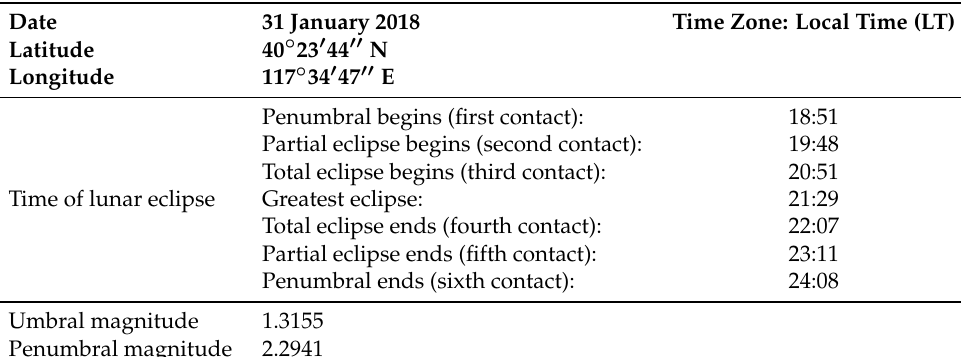
Table 1. Parameters of the Super Blue Blood Moon (SBBM) on 31 January